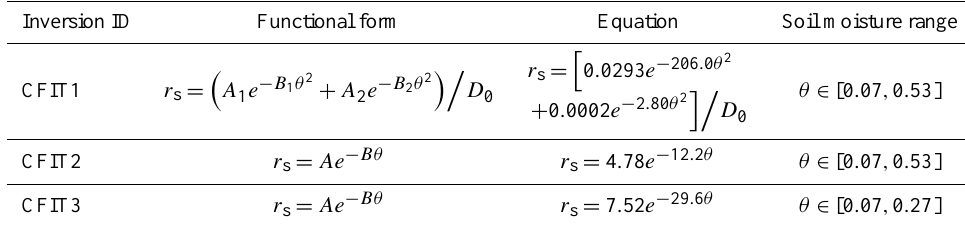
Table 4. Comparison of different empirical soil resistance curves for the sensitivity study (Fig. 6). The loam soil in Table 2 is used for the comparison.